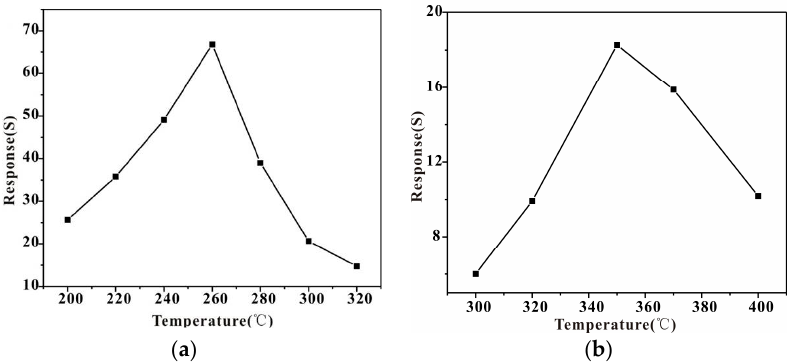
Figure 7. Operating temperature of ( a ) the Au-modified HPSCZNs and ( b ) the unmodified HPSCZNs-based sensors to 30 ppm of trimethylamine (TMA).